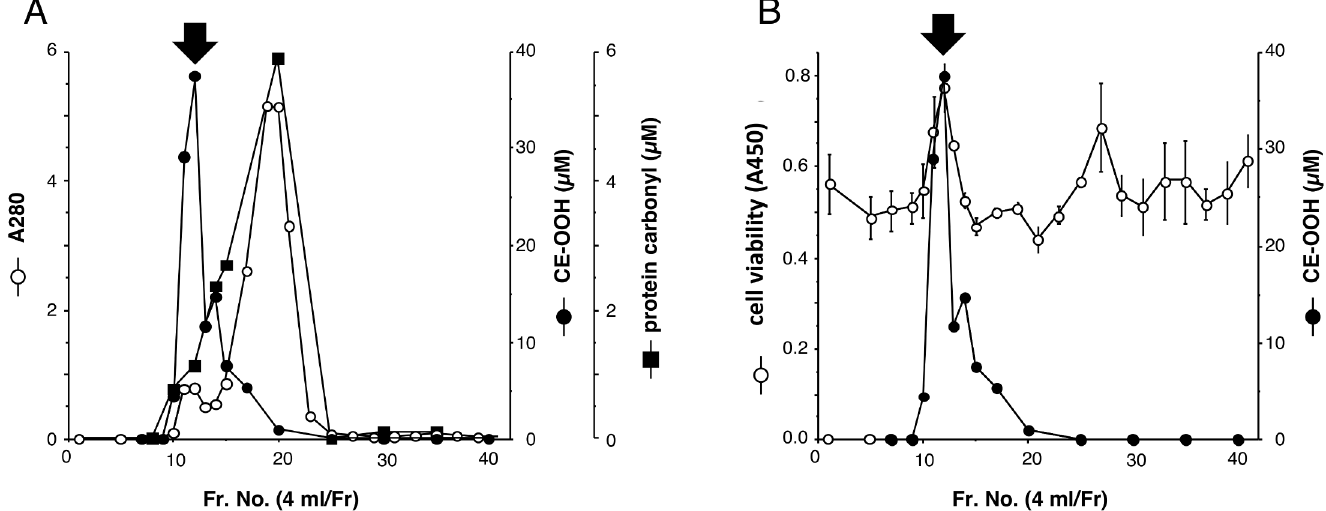
Fig 2. Distribution of oxidized products in Sephacryl S-300 gel chromatography. A. Oxidized human serum were fractionated by Sephacryl S-300 gel chromatography, and contents of protein (A280), cholesterol ester hydroperoxide (CE-OOH), and protein carbonyl were determined, respectively. B. Both AoSMC viability and CE-OOH contents are plotted. The peak of maclomolecule proliferator for vessel cells and CE-OOH at Fr.12 is indicated by black arrow.